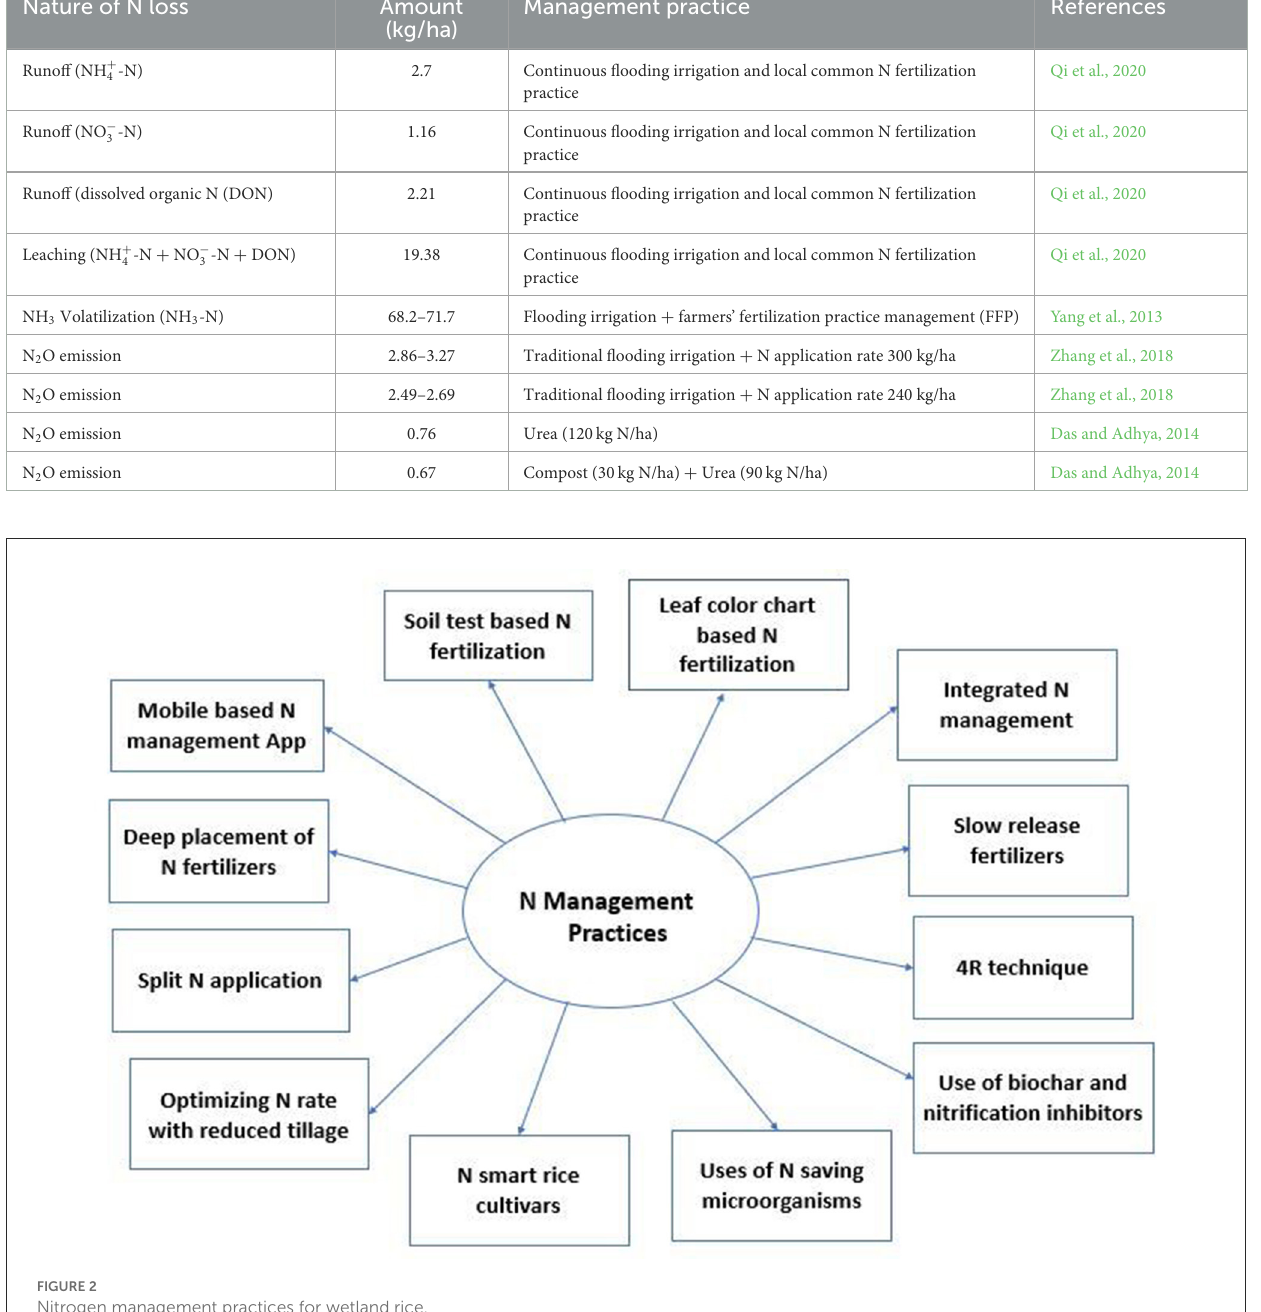
FIGURE2 Nitrogen management practices for wetland